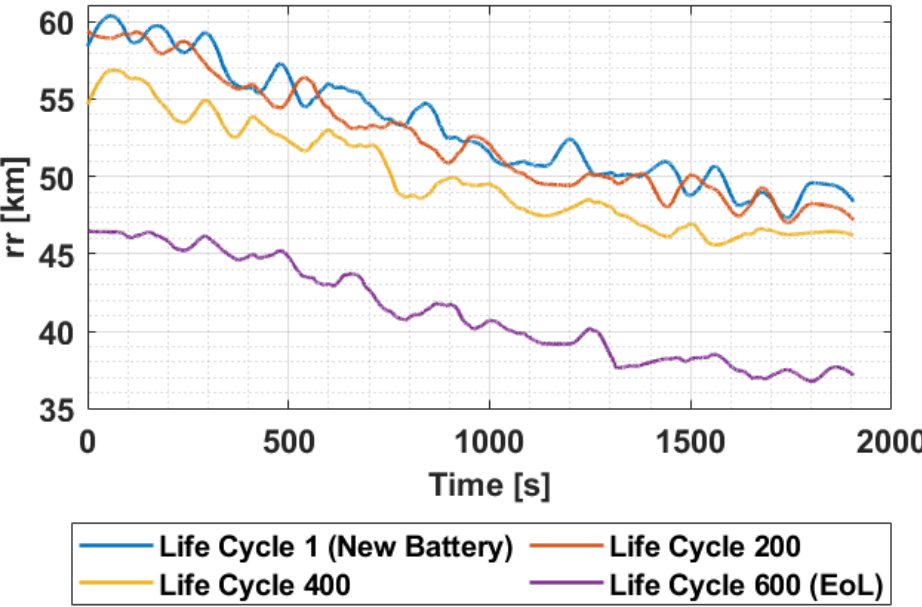
Figure 29. Comparison of the residual driving range estimated for different battery aging in the case of DoD100.